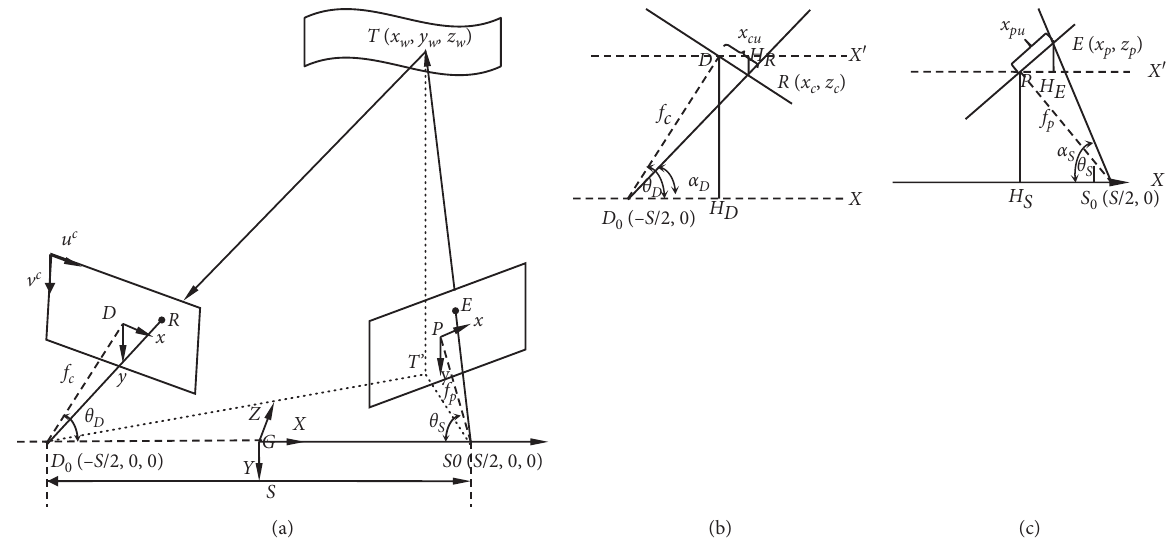
Figure 4: The CSL imaging system. (a) The triangular calculation model of CSL. (b) Camera side. (c) Projection